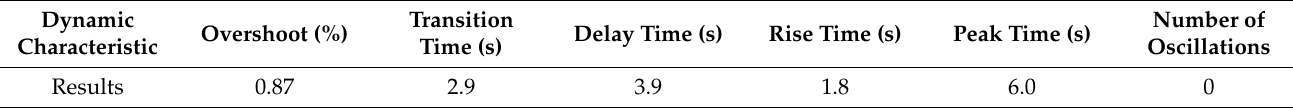
(b)(a) Figure 11. Electric field distribution of the bimetallic ring probe: ( a ) top view and ( b ) side view.